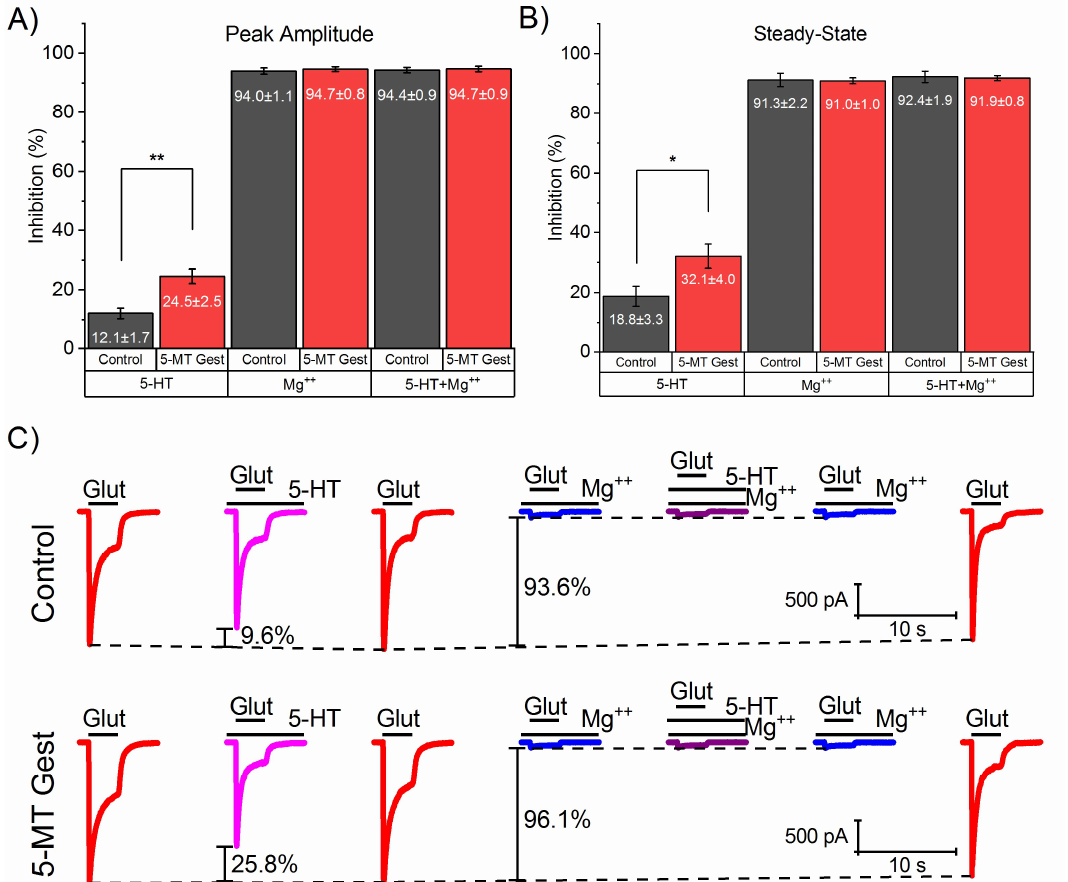
Figure 3. E ff ect of 5-HT (30 µ M) on both peak amplitude and SS of I Glut (100 µ M) in the presence and absence of Mg ++ (1 mM). Peak amplitude ( A ) shows a significant di ff erence (t 14.43 = 4.108, p = 0.001) between inhibition of 12.08 ± 1.75% in the control group ( n = 9), and 24.48 ± 2.46% in those o ff spring from treated mothers ( n = 9) when cells were perfused with 5-HT (t 14.43 = 4.108, p = 0.001), however, no di ff erences were found between the groups when Mg ++ was applied (t 14.94 = 0.49, p = 0.63) nor when Mg ++ and 5-HT were co-applied (t 15.99 = 0.29, p = 0.78). Similarly, SS ( B ) shows di ff erence between groups in the presence of 5-HT (Control: 18.83 ± 3.32%; 5-MT Gest: 32.14 ± 4.03%; t 15.44 = 2.55, p = 0.02), but not when it was co-applied with Mg ++ (t 10.92 = − 0.21, p = 0.84) or in the presence